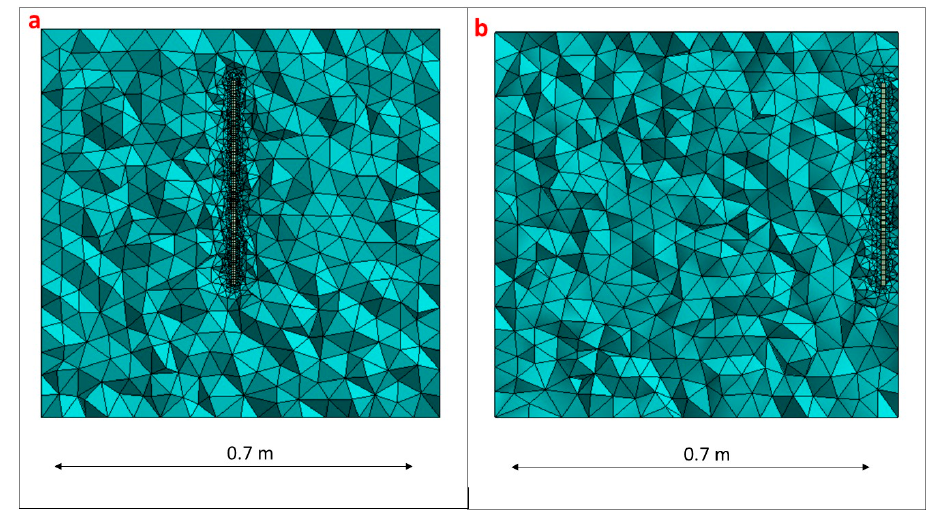
Figure 14. Simulation model used: ( a ) Disk with “infinite” water medium; and ( b ) disk close to rigid wall (25 mm). wall (25 mm).